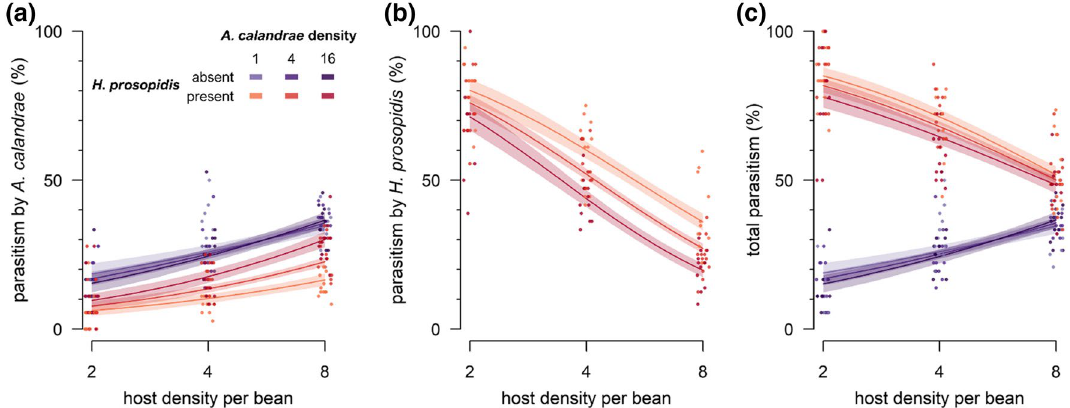
Figure 3. Percent parasitism by each or both parasitoids and its host density dependence. ( a ) Parasitism by the native parasitoid Anisopteromalus calandrae ; ( b ) parasitism by the nonnative parasitoid Heterospilus prosopidis ;